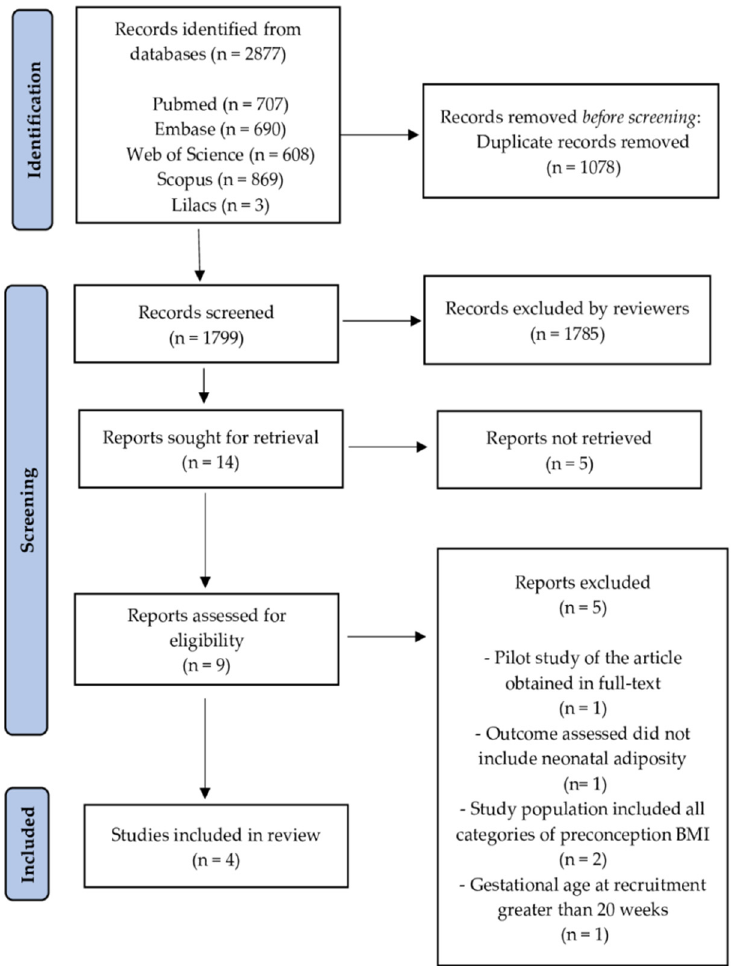
Figure 1. Preferred Reporting Items for Systematic Reviews and Meta-Analyses (PRISMA) 2020 flow diagram: identification and selection of studies process. BMI: body mass index.